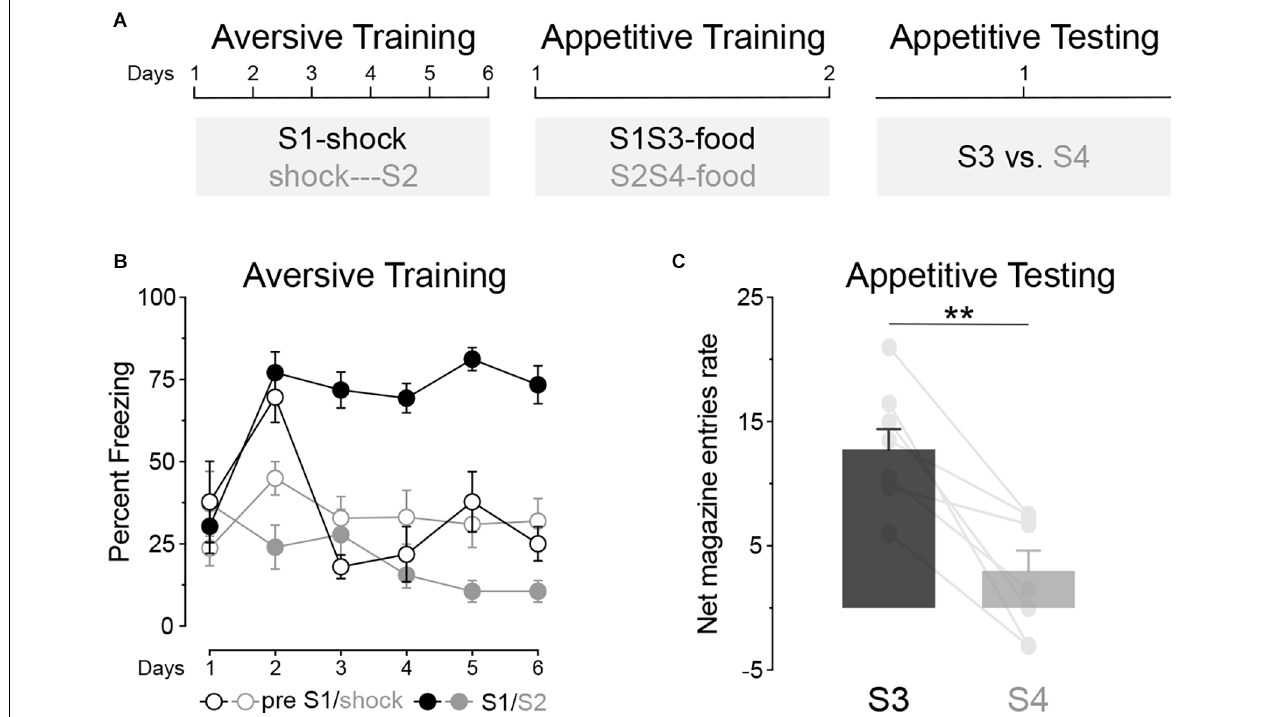
FIGURE 2 | The opposing effect of an aversive excitor and an aversive inhibitor on appetitive conditioning. (A) Design of Experiment 1; S1/S2/S3/S4: clicker, tone, flashing light or constant light (counterbalanced). (B) Aversive conditioning: S1 became an aversive excitor whereas S2 became into an aversive inhibitor. (C) Appetitive conditioning test: stimulus S3 elicited significantly more appetitive responding than stimulus S4 at test. Error bars denote ± 1 SEM. Asterisks denote significant effect (** p <